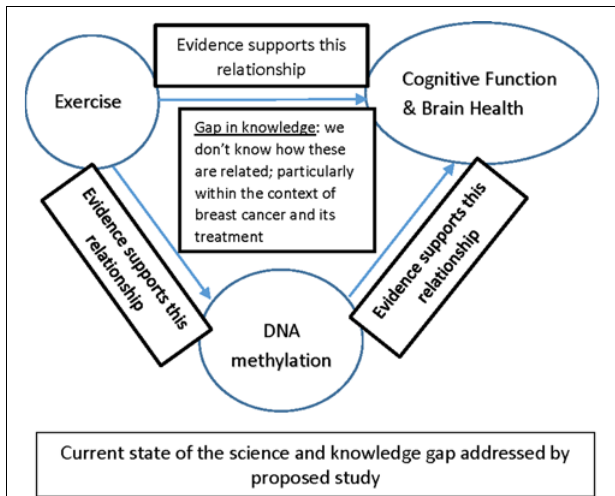
FIGURE 3 | Gap in